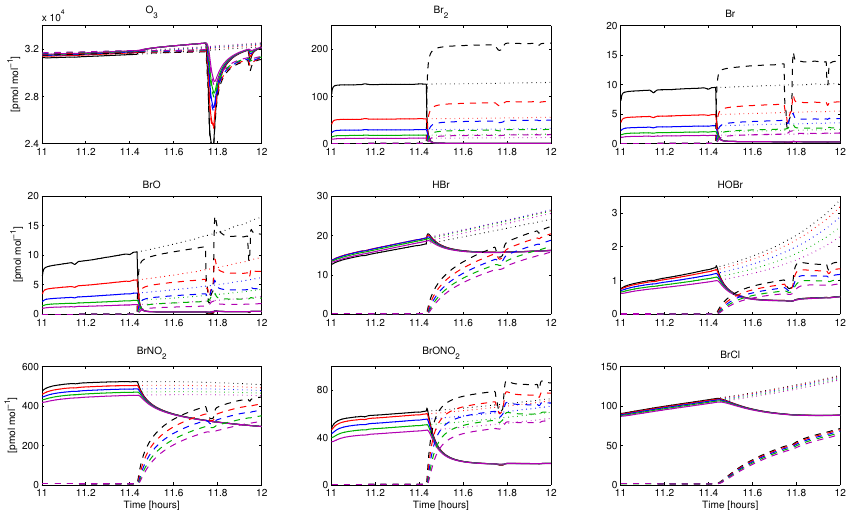
Fig. 14. Mixing ratios of O 3 and the major bromine compounds, in the lowest five layers of the model column. Black, red, blue, green, and purple lines represent levels with their centres at 0.5, 2, 4.5, 8 and 12.5m, respectively. Solid and dotted lines represent mixing ratios from the model runs with a sea based Br 2 source (solid lines are for the low-tide scenario, dotted lines for the high-tide scenario). Dashed lines represent mixing ratios from the low-tide model run with a beach based Br 2